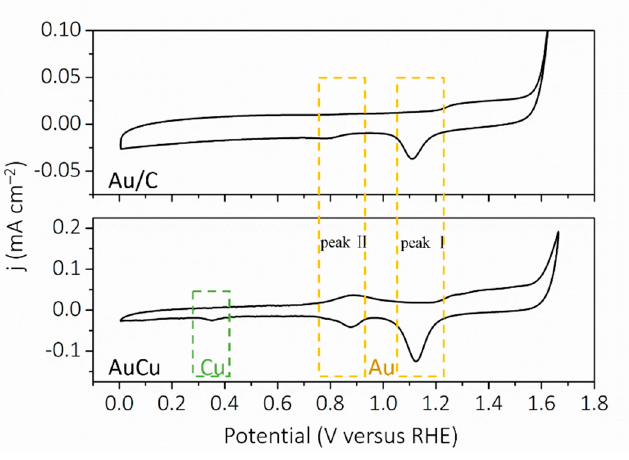
Figure 5. CV curves of AuCu and Au/C in Ar-saturated 0.1 M KOH at 10 mV s –1 .